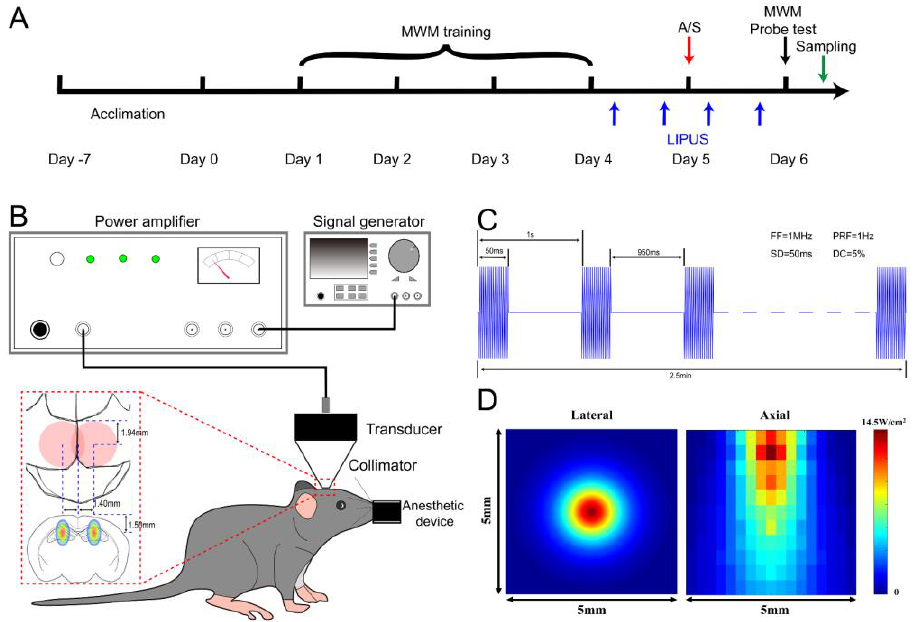
Figure 1. Overview of the LIPUS application. ( A ) Experimental design. ( B ) Diagram of the LIPUS setup and dorsal hippocampus positioning. ( C ) Acoustic intensity distribution of the lateral and axial direction was expressed by the spatial-peak pulse-average intensity (ISPPA). ( D ) Illustration of ultrasound stimulation parameters: fundamental frequency (FF) of 1 MHz, pulse repetition fre- quency (PRF) of 1 Hz, sonication duration (SD) of 50 ms, and duty cycle (DC) of 5%. (PRF) of 1 Hz, sonication duration (SD) of 50 ms, and duty cycle (DC) of